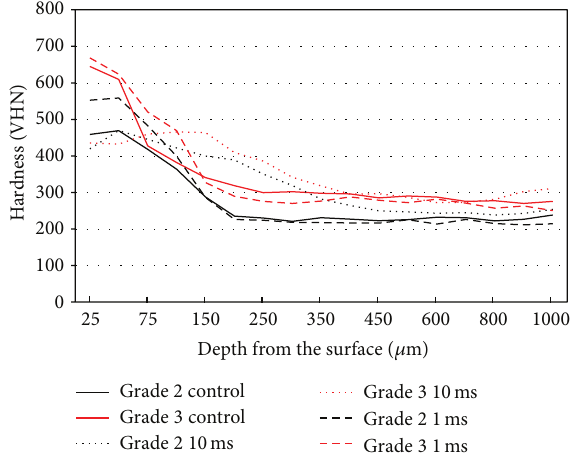
Figure 9: Hardness depth profiles from cast surface for control specimens (grade 2: black solid line, grade 3: red solid line) and specimens laser-treated with two different spot diameters (1.0mm and 1.6mm) at a constant emission current of 240 A and a pulse duration (10ms).